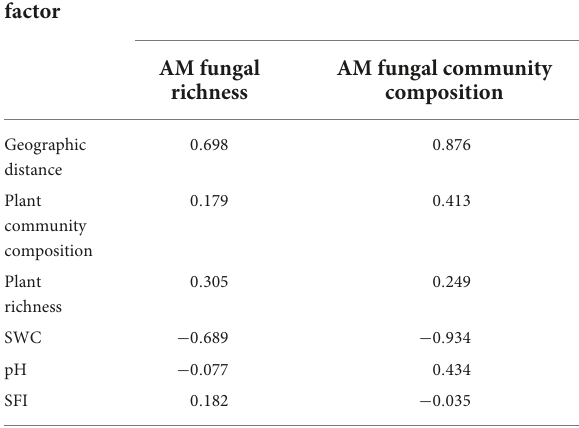
TABLE 1 Standardized total contribution rate of main factors driving AM fungal richness and community composition in the near-bank